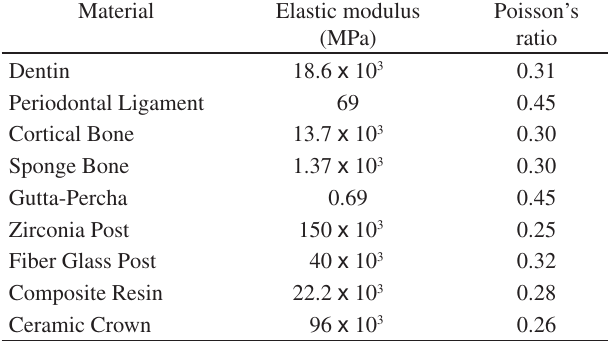
Table 1. Elastic properties of the materials involved in the FEM calcula- tion 1